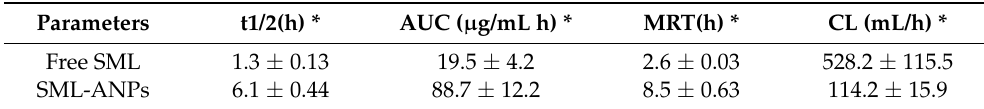
Table 2. Pharmacokinetic parameters of SML concentration after intravenous administration of free SML and SML-ANPs to rats.